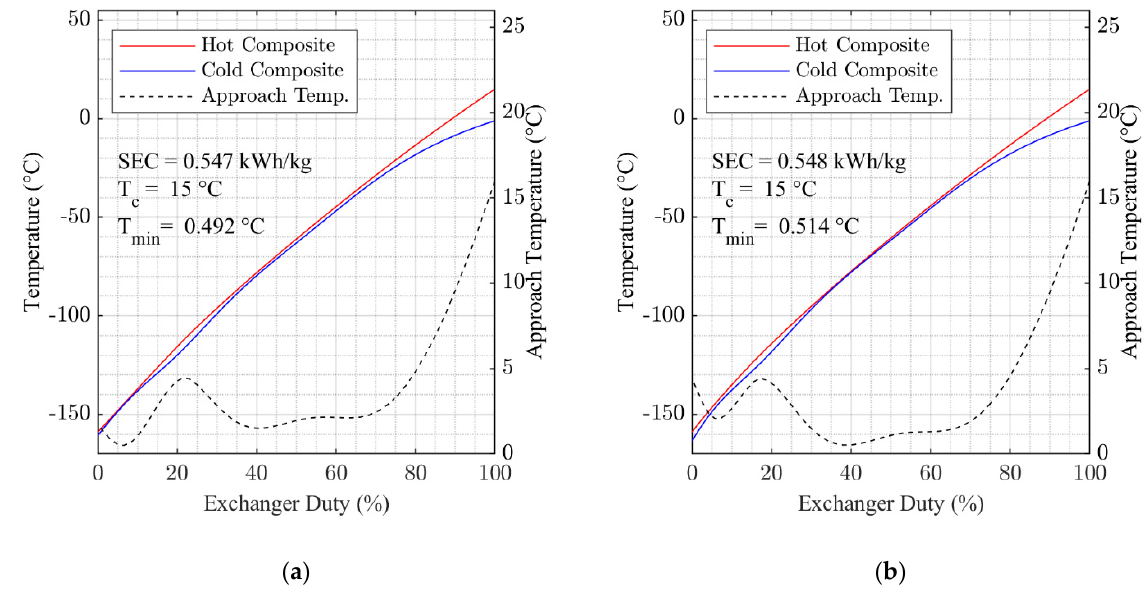
Figure 3. Composite Curves and Key Performance Parameters for HX-1, MR Pre-cooling Process: ( a ) Case B; ( b ) Case C.